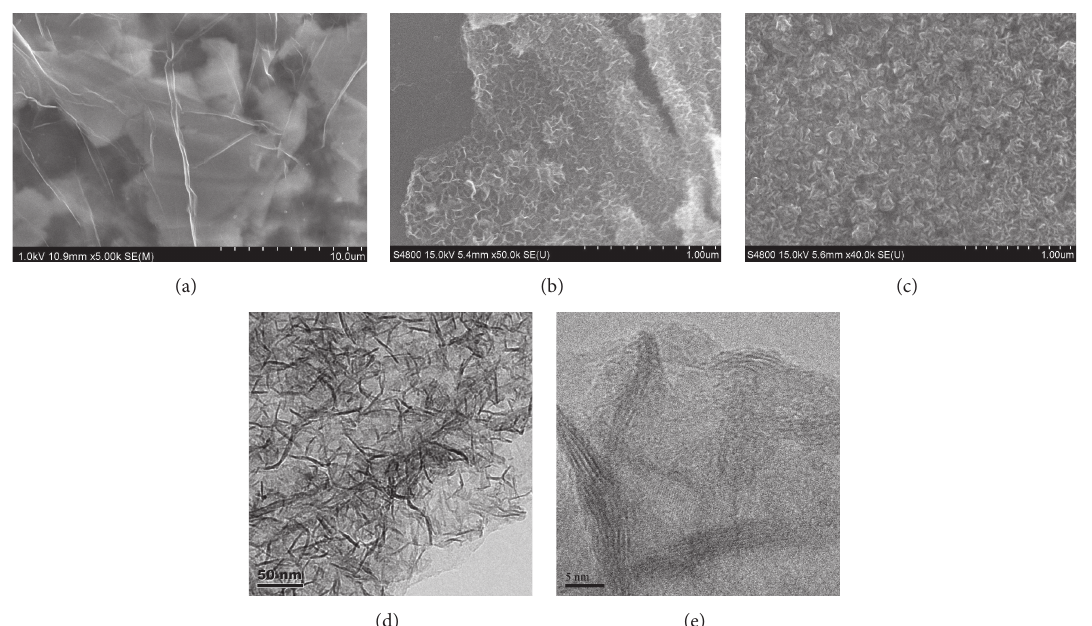
Figure 6: SEM images of graphene (a), 60-MnO 2 /graphene (b), and 100-MnO 2 /graphene (c); TEM (d) and HRTEM (e) images of 60- MnO 2